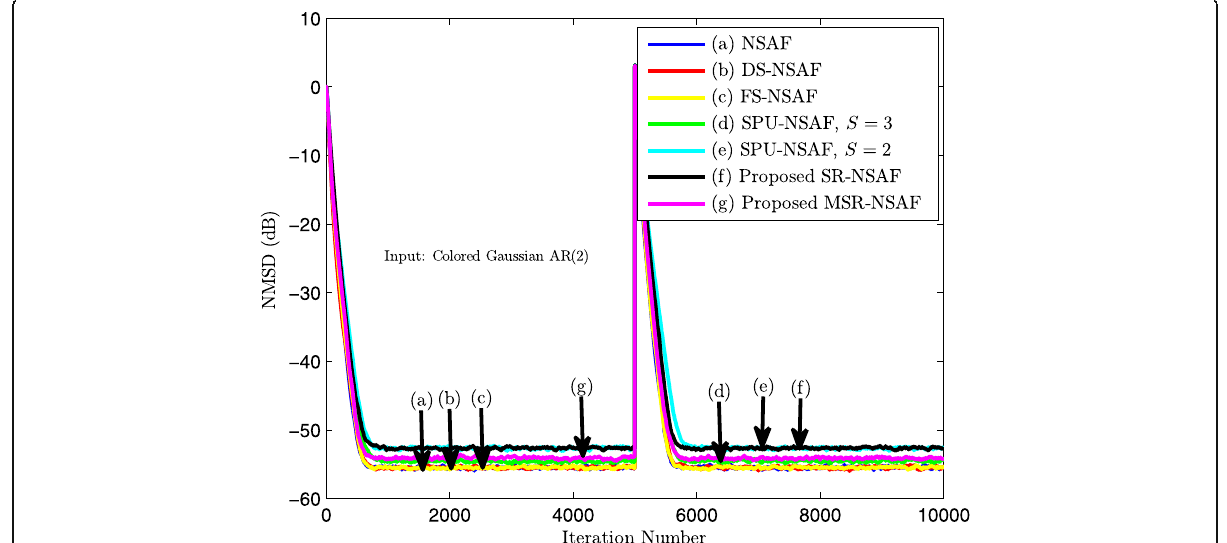
Fig. 9 NMSD learning curves for tracking performance of NSAF, DS-NSAF, FS-NSAF, SPU-NSAF, SR-NSAF, and MSR-NSAF with N = 8 and μ = 0.5